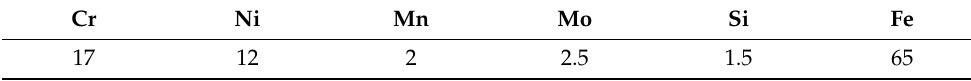
Table 1. Chemical composition of 316Lss (mass fraction, %).